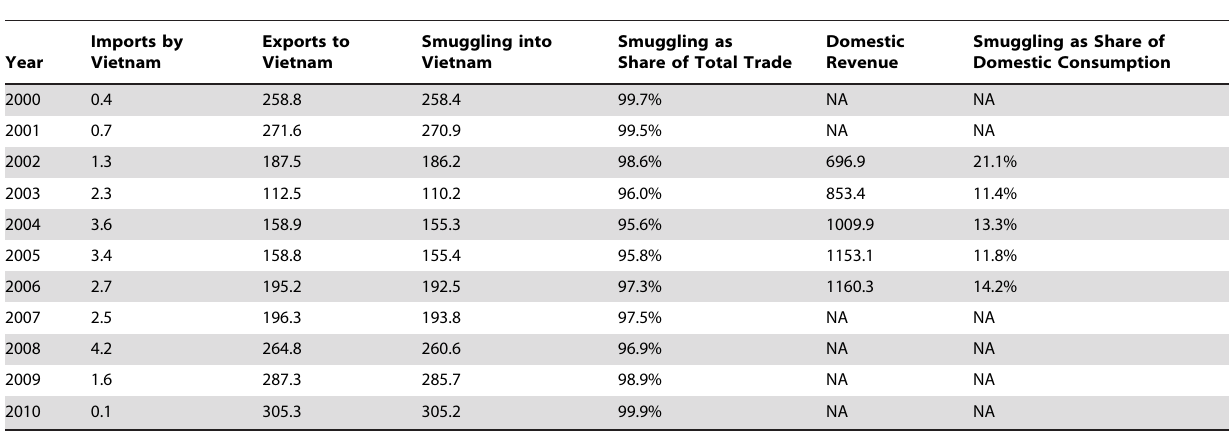
Table 3. Net Smuggling into Vietnam and Its Share of Domestic Consumption (millions of US